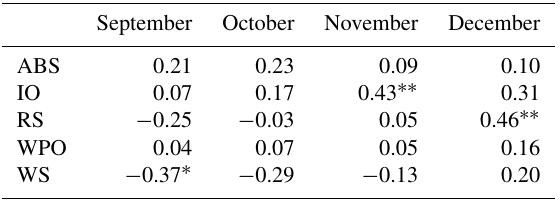
Table 2. Correlation coefficients between regional sea ice ex- tent (SIE) and monthly Southern Annular Mode